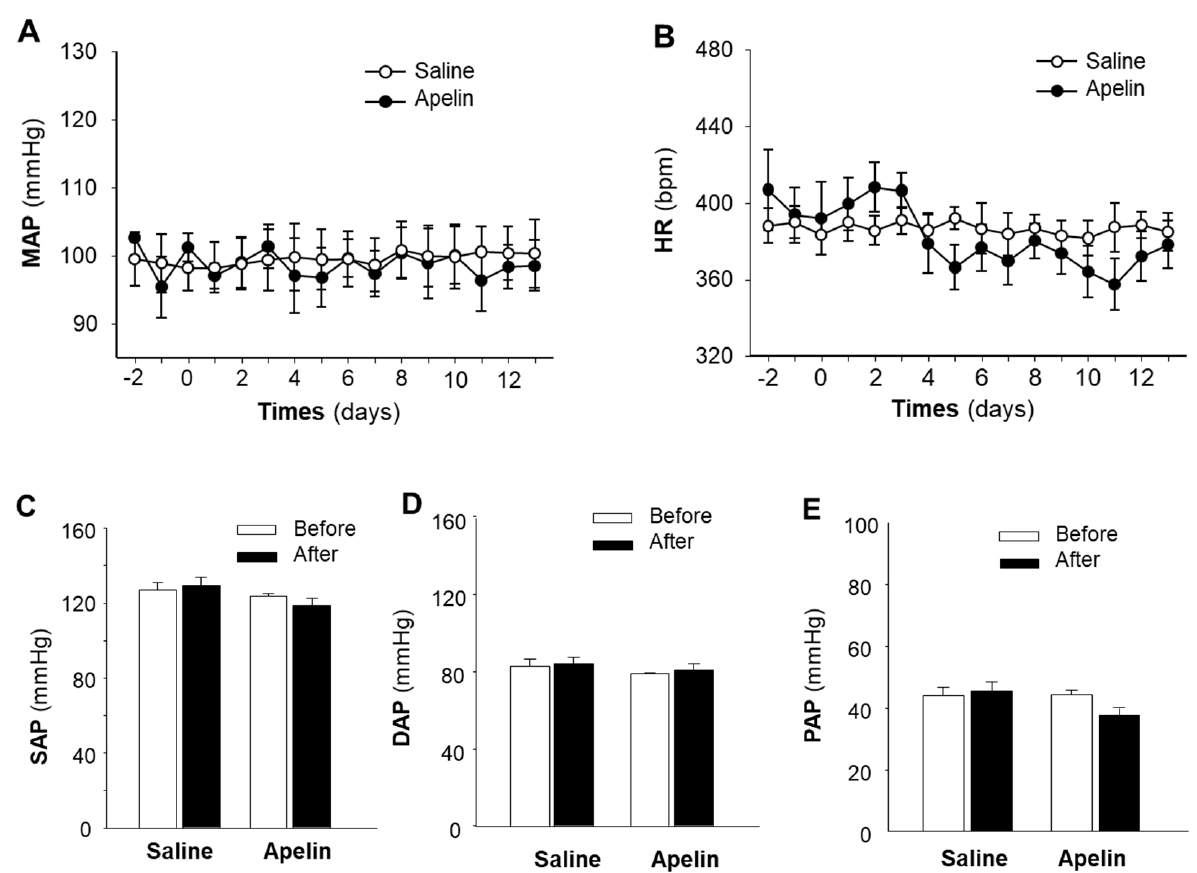
Figure 1. Effect of chronic subcutaneous infusions of apelin on BP and HR. BP and HR were recorded using the telemetry technique in conscious SD rats, before and during subcutaneous infusion of [pyr 1 ]-apelin-13 or saline (control) through osmotic minipumps, as described in the Methods. Time courses of changes in MAP ( A ) and HR ( B ) were determined before and during subcutaneous infusions of apelin (filled circle) or saline (empty circle). ( C – E ), bar graphs show the systolic arterial pressure (SAP), diastolic arterial pressure (DAP), and pulse arterial pressure (PAP) recorded before (empty bar) and after (filled bar) subcutaneous infusions of apelin-13 or saline. Values are expressed as means ± SE ( n = 6 for each group).